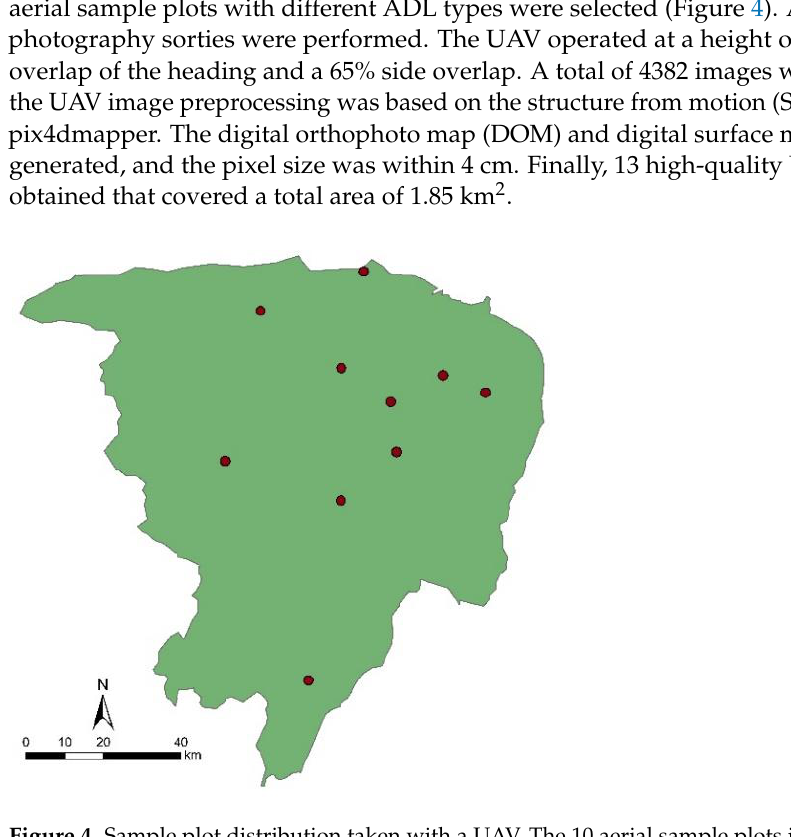
Figure 4. Sample plot distribution taken with a UAV. The 10 aerial sample plots included all levels of the ADL and were evenly distributed in the study area, which were representative of the aeolian desertification status in Zhenglan Banner.